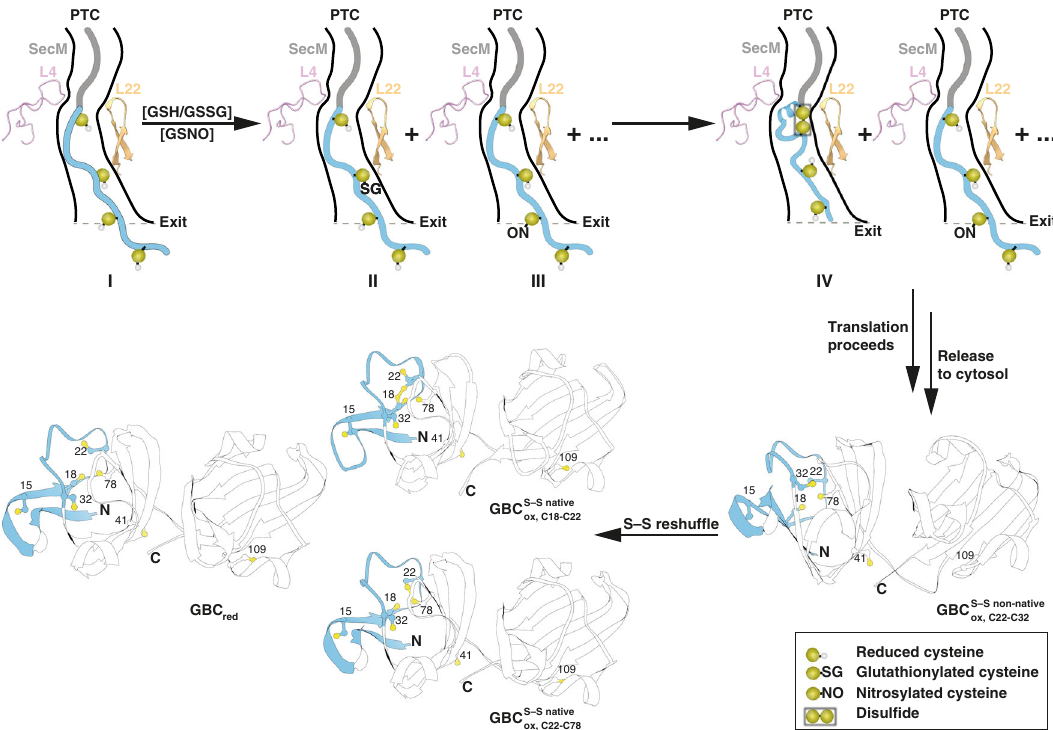
Fig. 4 Disul fi de bond formation within NCs and after release. Free thiols of GBC nascent chain (I) are modi fi ed by glutathione (GSH) (II) or S - nitrosoglutathione (GSNO) (III). Such modi fi ed cysteine residues with enhanced electrophilicity can be attacked by thiol groups of neighboring cysteine residues to form disul fi de bonds (IV). In the released NC, non-native disul fi de are either reshuffeled to form native disul fi de bonds (C18-C22) or reduced pending on translation rate. SecM is shown in dark gray, the nascent chain in light blue, L4 in light pink, and L22 in light orange. Cysteine residues are shown as yellow